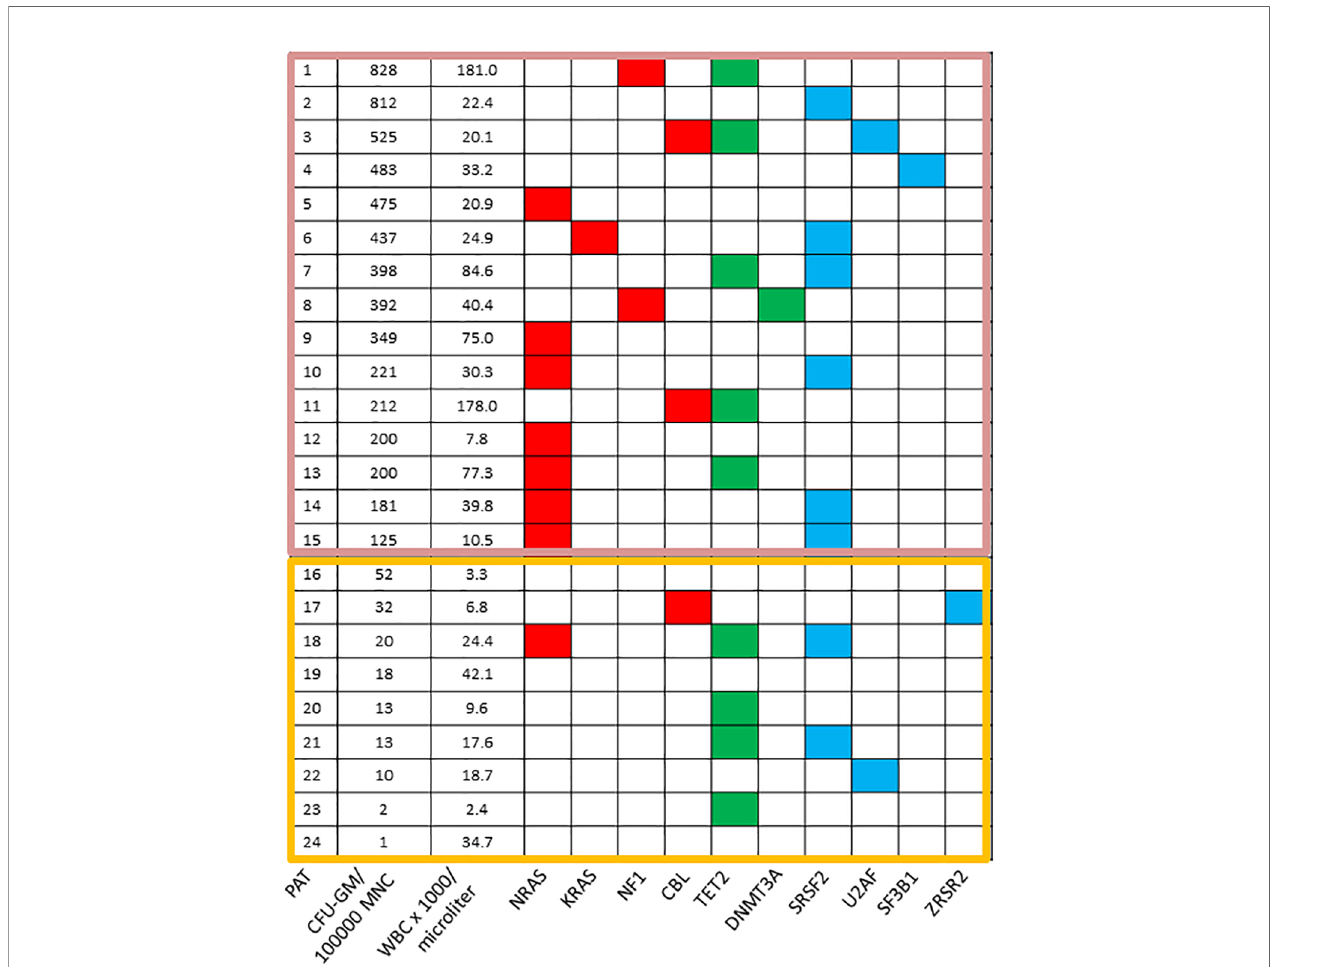
FIGURE 2 | Mutation pro fi les in CMML according to spontaneous CFU-GM growth. Each row corresponds to one patient. The fi rst column indicates the patient number, the second the number of CFU-GM per 10 5 peripheral blood mononuclear cells (PBMNC), the third the white blood cell (WBC) count and all other columns represent the status of genes. Colored squares indicate mutated, white squares wild-type genes. The clores of mutant genes indicate the most affected functional categories. Red, green, and blue indicate RAS-pathway, epigenetic factors, and splicing factors, respectively. Mutations in the components of the RAS-pathway were found in 12/15 (80%) CMML patients with high colony growth ( ≥ 100 CFU-GM/10 5 PBMNC) and in 2/9 (22%) patients with low spontaneous colony formation (<100 CFU-GM/10 5 PBMNC). [adapted from Geissler, K. MEMO 2016